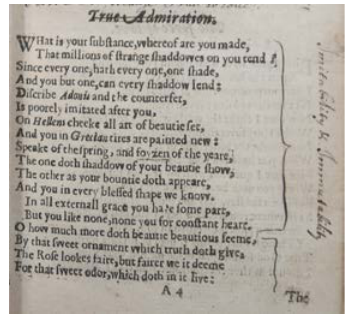
Fig. 5 – Folger STC 22344 Copy 2, sig. A4r